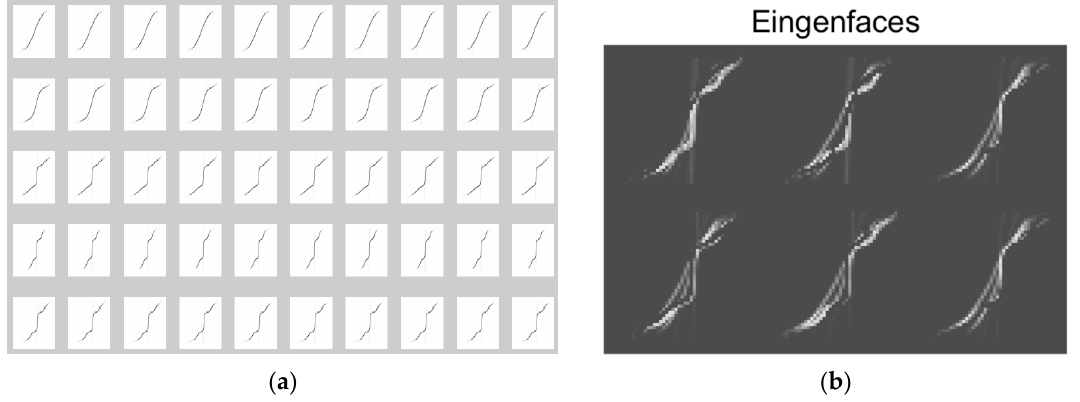
Figure 14. AVPCA databases under variable speed environment, w r ∈ [1600, 2400] rpm: ( a ) the training databases and ( b ) the generated eigenfaces.